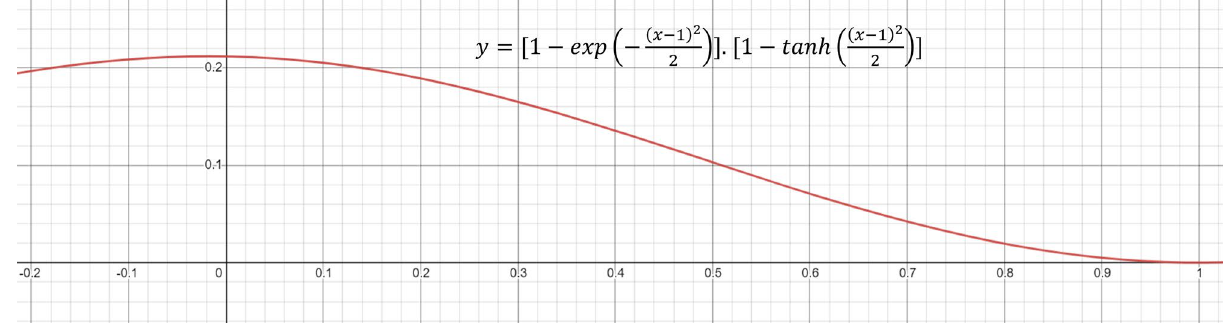
Figure 6. Plot of the product of the rank generating functions used in the proposed method. x denotes the prediction probability of a class and y represents the fuzzy rank